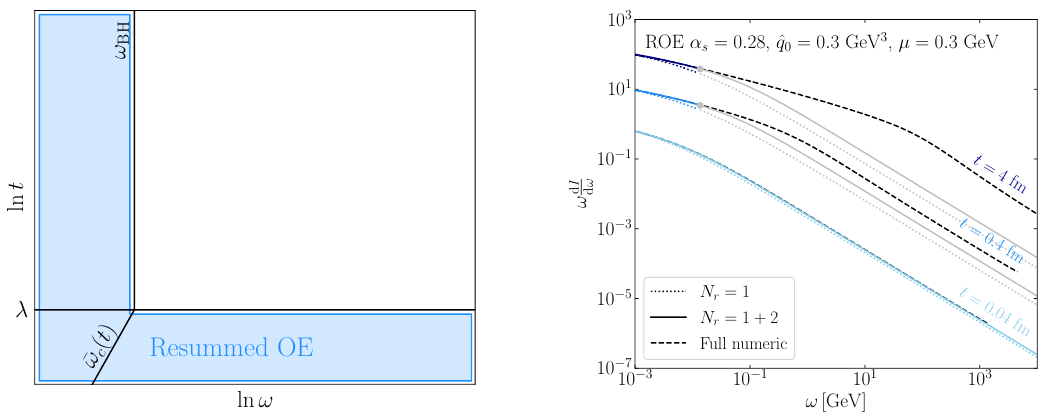
Figure 5 . Left: the sketch of region of validity (and convergence) of the resummed opacity expansion for different propagation length t and emission energy ω . Right: the induced emission spectrum for gluons in the resummed opacity expansion. The gray part of the curves denotes regions, where the expansion is not valid. With the parameters presented, λ = 0 . 06 fm. The full numeric solution is also presented with dashed